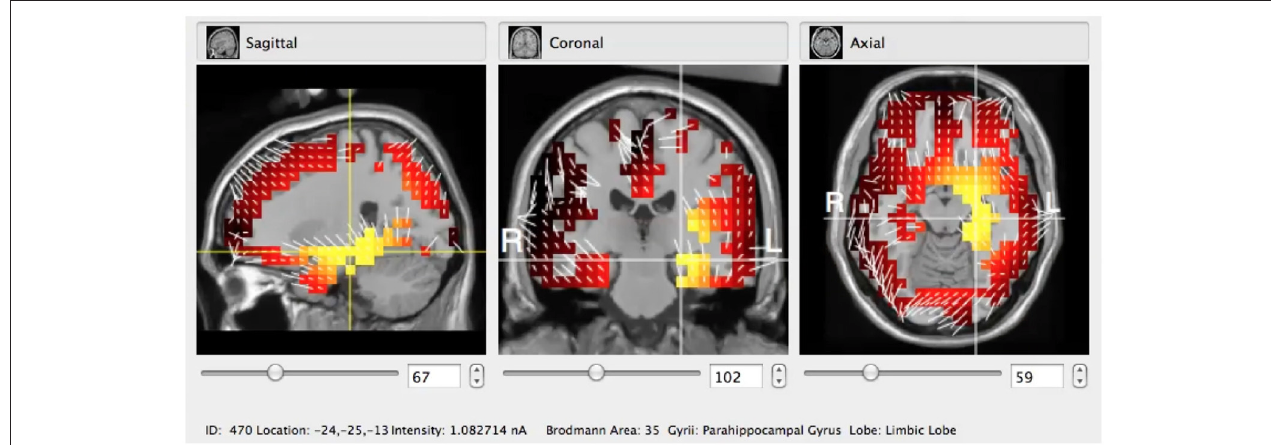
FIGURE 3 | Typical results of GeoSource BA activity visualization on the brain cortex so-called Flat Map. Increase of activity in BA21 (Middle Temporal Gyrus, Temporal Lobe) and BA19 (Precuneus Lobe, Parietal Lobe) is indicated.